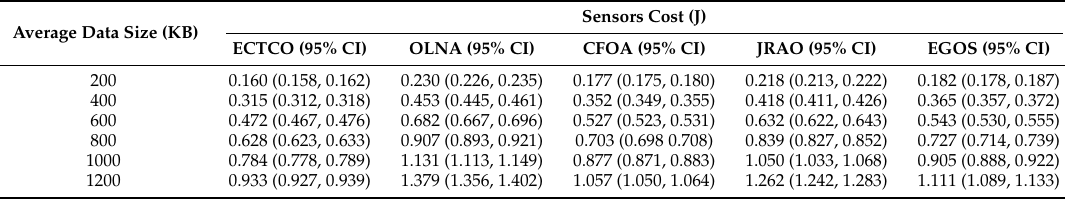
Table 5. Sensors cost versus data size d .